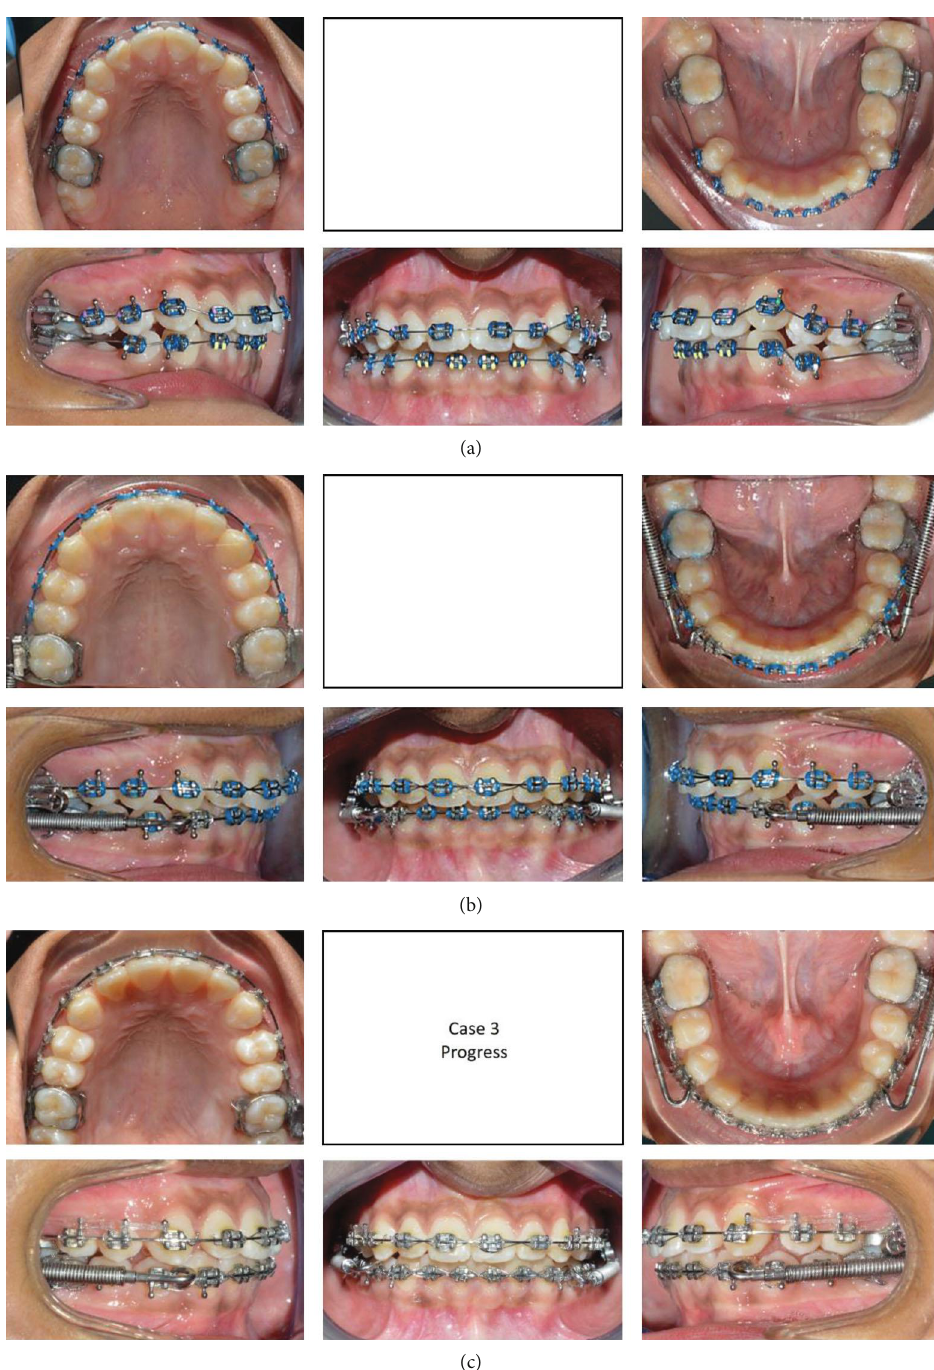
Figure 16: (a – c) Progress treatment intraoral photographs of the